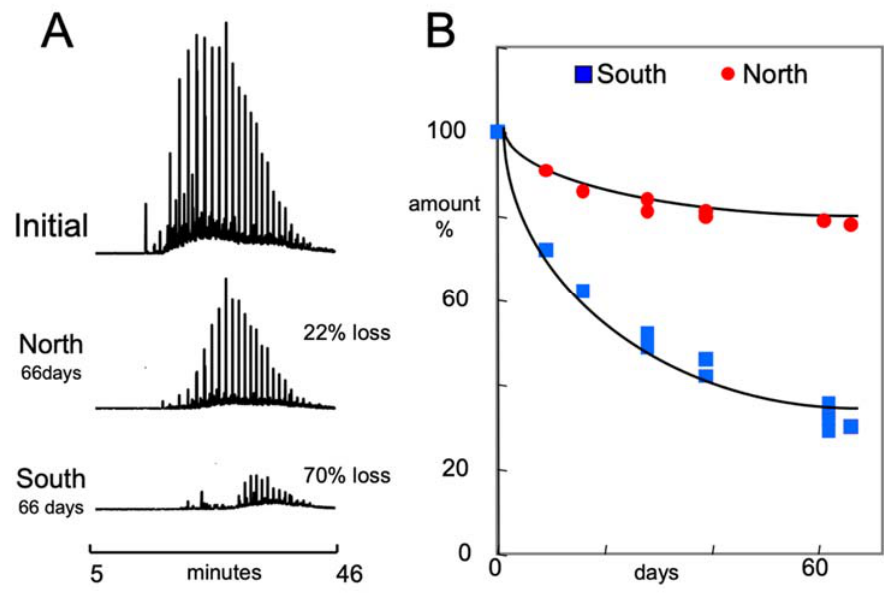
Figure 6. Total ion chromatograms of the initial crude oil, and of the oil exposed to water from the